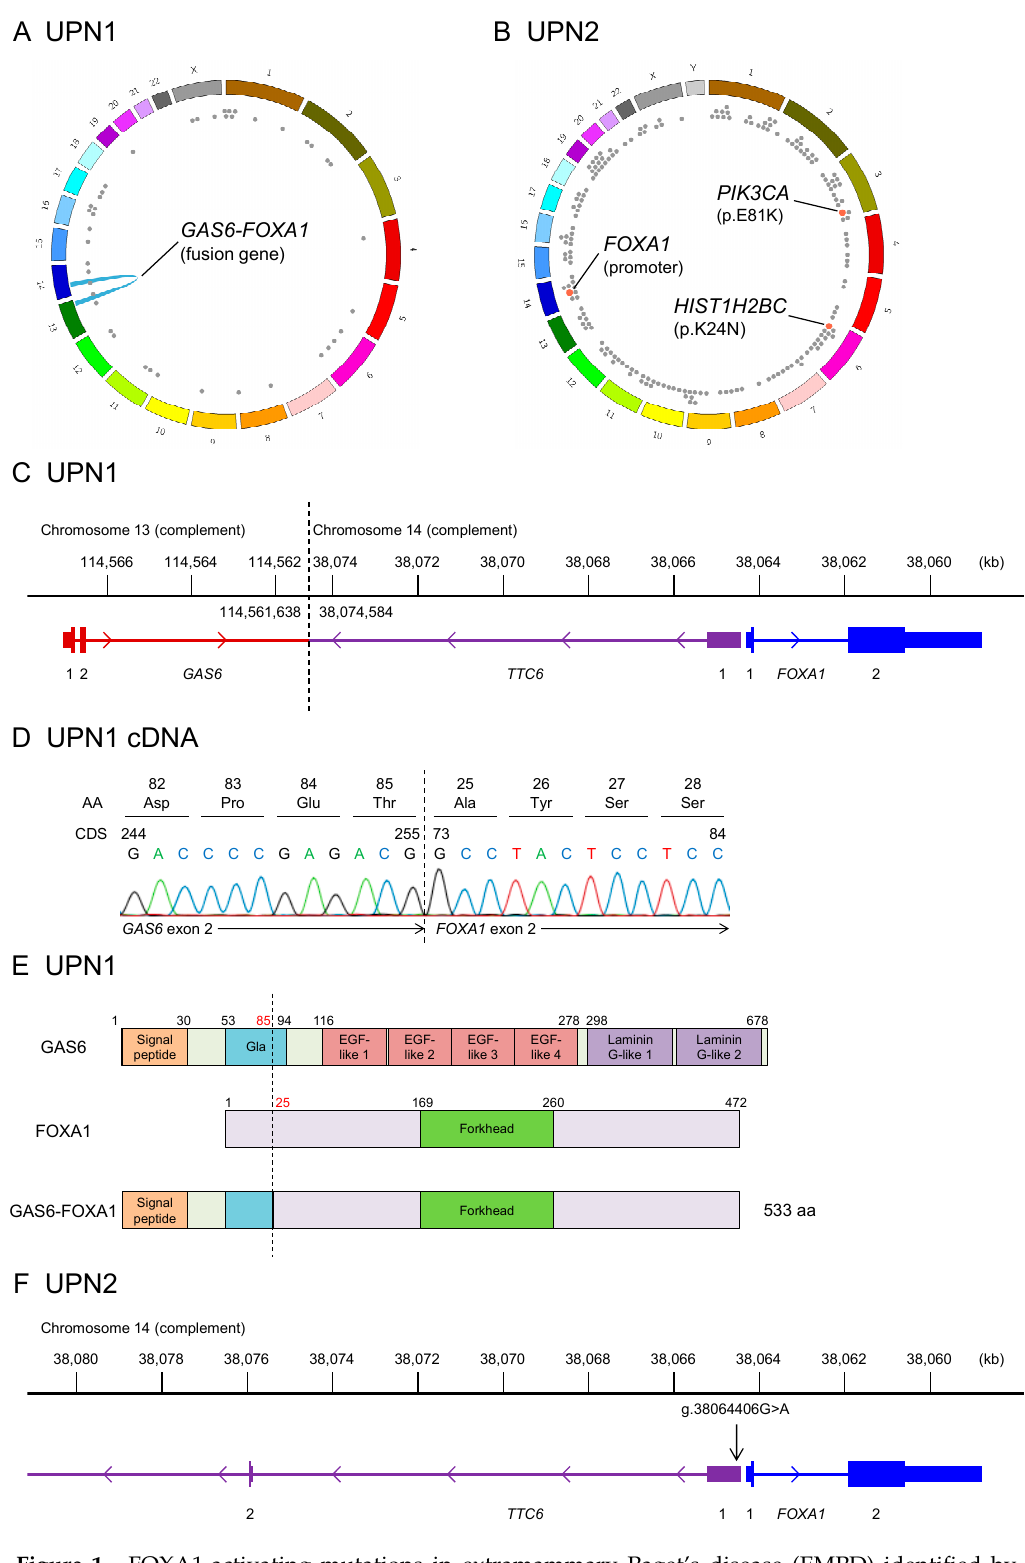
Figure 1. FOXA1-activating mutations in extramammary Paget’s disease (EMPD) identified by whole-genome sequencing. ( A , B ) Summary of somatic mutations identified in patients UPN1 ( A ) and UPN2 ( B ). Dots indicate nonsynonymous mutations, and the blue arch indicates gene fusion. We